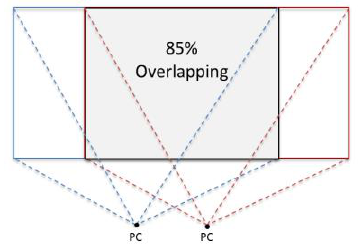
Figure 2. Extract images from a recorded